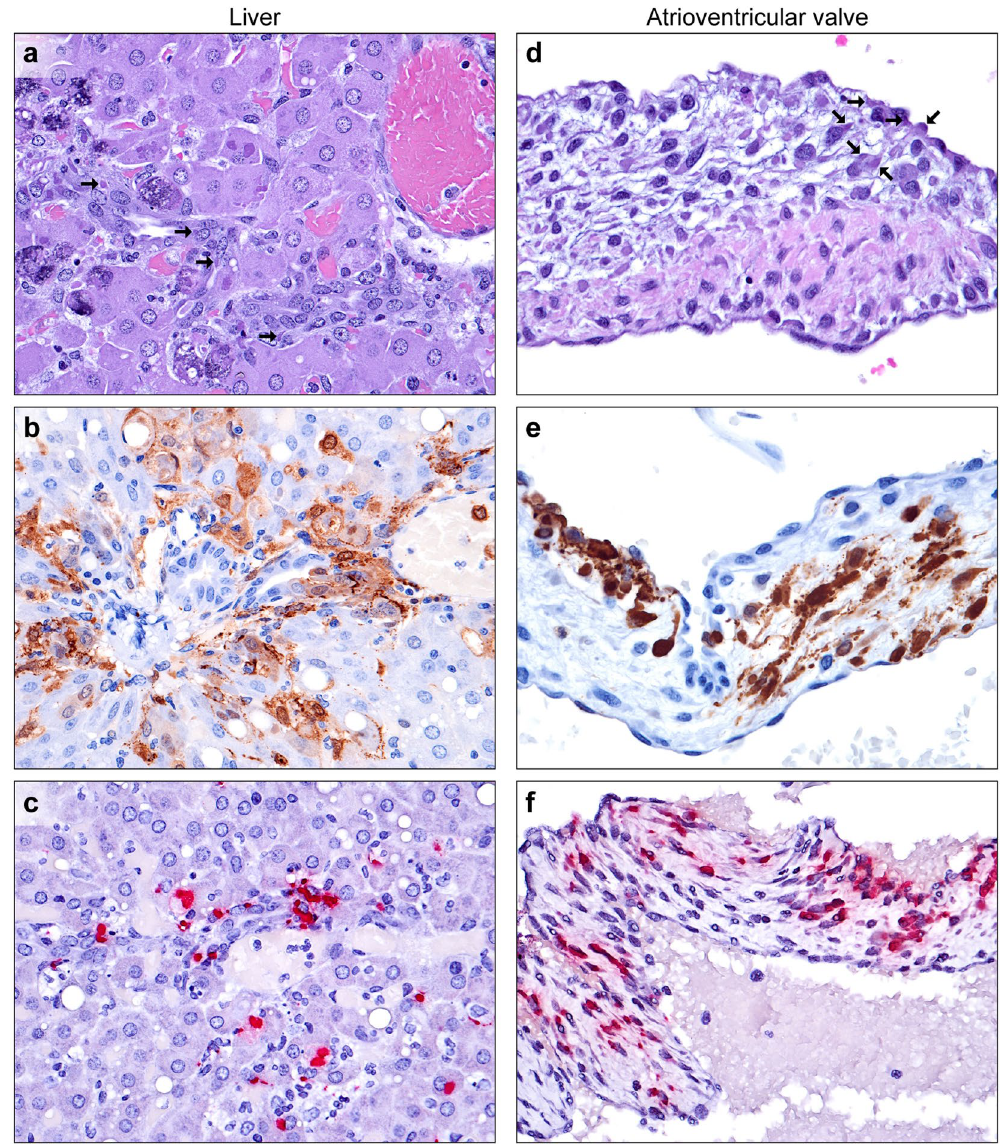
Figure 1. EBOV infection of the liver and heart. ( a ) Oval cell infection of the liver. Parallel streams of basophilic oval cells form duct-like structures adjacent to a portal triad, with frequent large eosinophilic toamphiphilic intracytoplasmic inclusion bodies (arrows, H&E). ( b ) Proliferating oval cells, hepatocytes, Kupffer cells, and intravascular monocytes (EBOV VP40 IHC: DAB chromogen and hematoxylin). ( c ) Oval cells, hepatocytes, and Kupffer cells (EBOV NP ISH: fast red chromogen and hematoxylin). ( d ) Valvular endocarditis of tricuspid valve cusp. Degeneration and necrosis of surface (atrialis) endocardial cells and stromal cells of the spongiosa, with infiltrating macrophages and frequent large eosinophilic to amphiphilic intracytoplasmic inclusion bodies (arrows, H&E). ( e ) Endocardial cells, stromal cells, and macrophages (EBOV VP40 IHC: DAB chromogen and hematoxylin). ( f ) Endocardial cells, stromal cells, and macrophages (EBOV NP ISH: fast red chromogen and